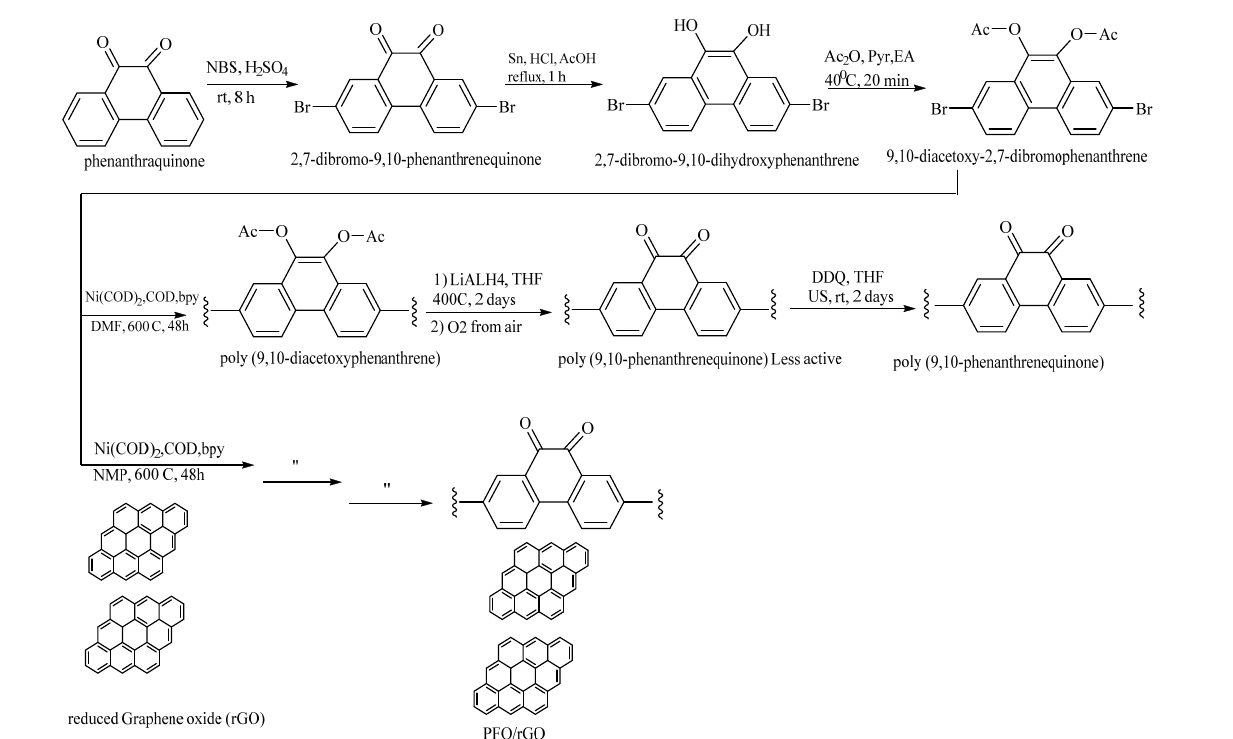
Figure 2. Direct polymerization of low voltage polymer.